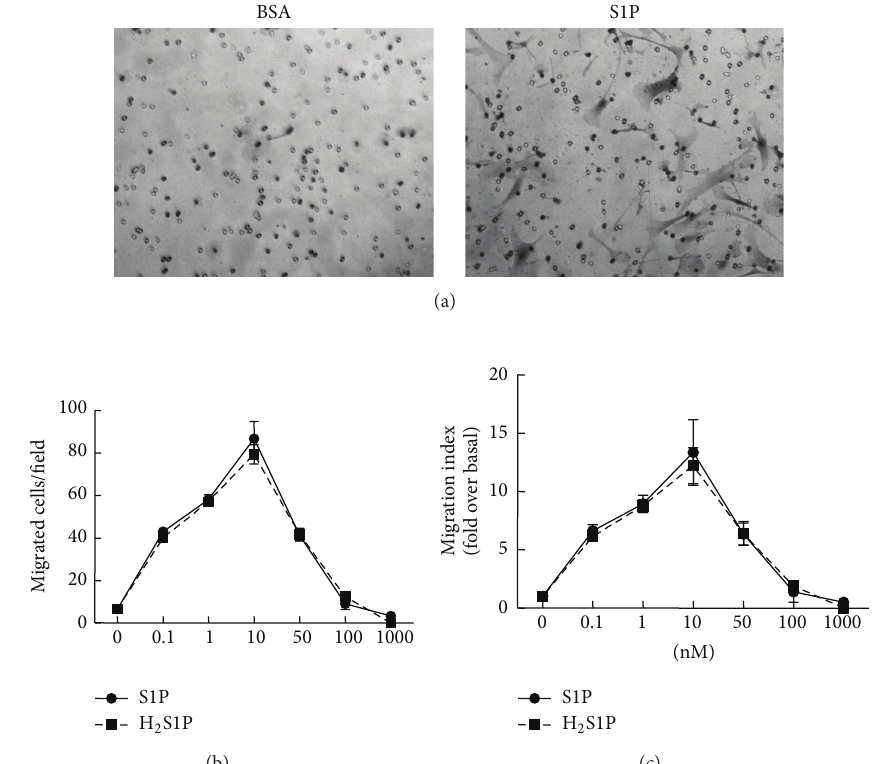
Figure 2: S1P-induced migration of human BMSCs via cell surface receptor. (a) The representative images of serum-starved BMSC migration stimulated with BSA or 1nM S1P for 4 h. (b)-(c) Serum-starved BMSCs were allowed to migrate for 4h in the presence of varying concentrations of S1P and H 2 S1P, as indicated. Migrated cells in a random fields (b) or migration index (fold over basal, (c)) shown were counted in 10 random fields per filter for each condition. Data are presented as the mean ± SD. ∗ 𝑃 < 0.05 , compared with control.